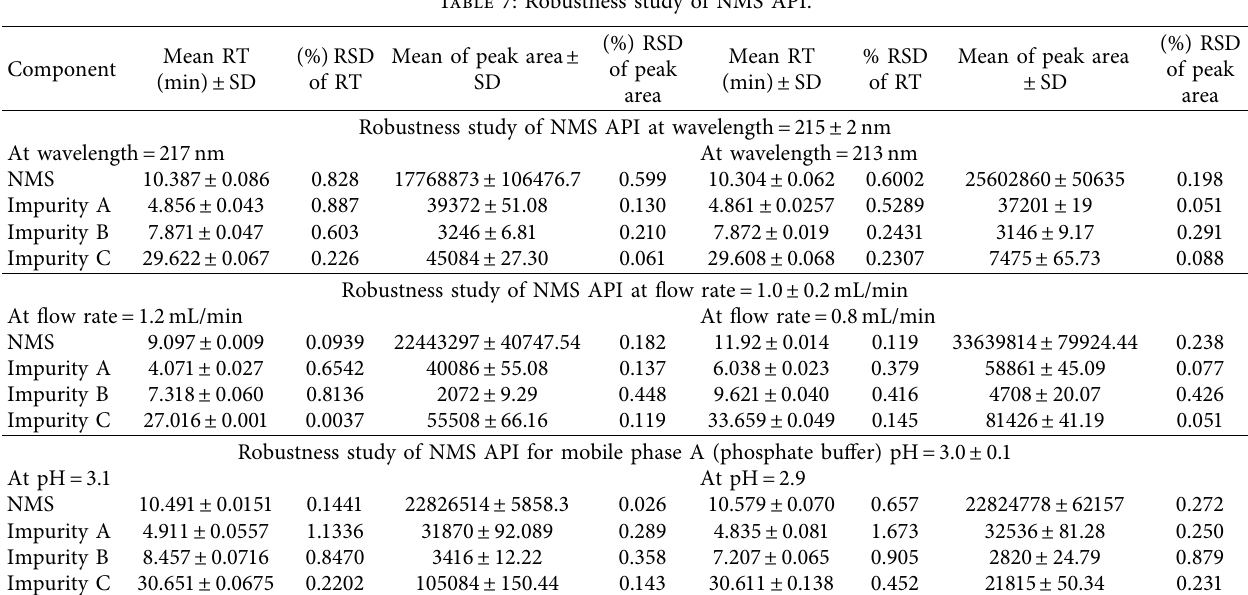
Table 7: Robustness study of NMS API.